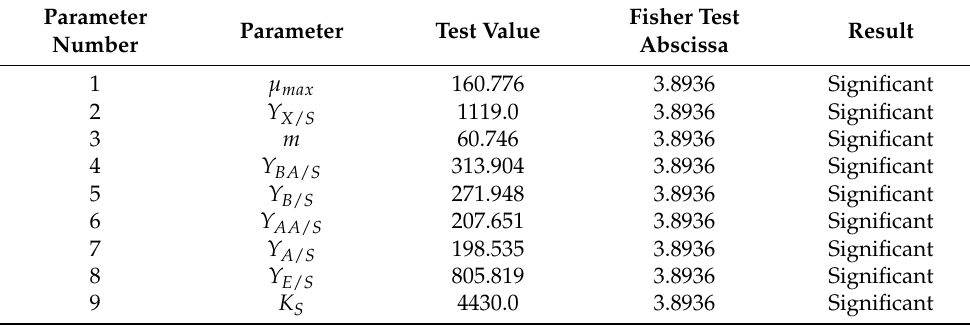
Figure 3. Parameter confidence intervals for the Reduced-Model with 9 parameters (95% probability). Table 6. Fisher F test of significance for the 9 parameters of the